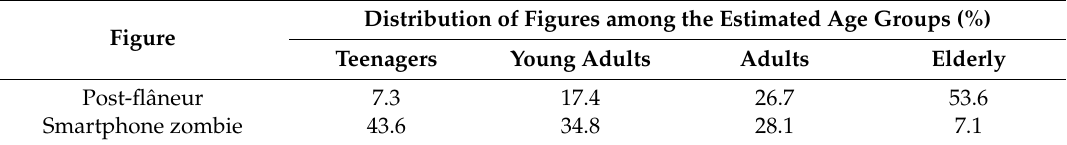
Table 4. Distribution of figures among the estimated age groups. Distribution of Figures among the Estimated Age Groups (%) Figure Teenagers Young Adults Adults Elderly Post-fl â neur 7.3 17.4 26.7 53.6 Smartphone zombie 43.6 34.8 28.1 7.1